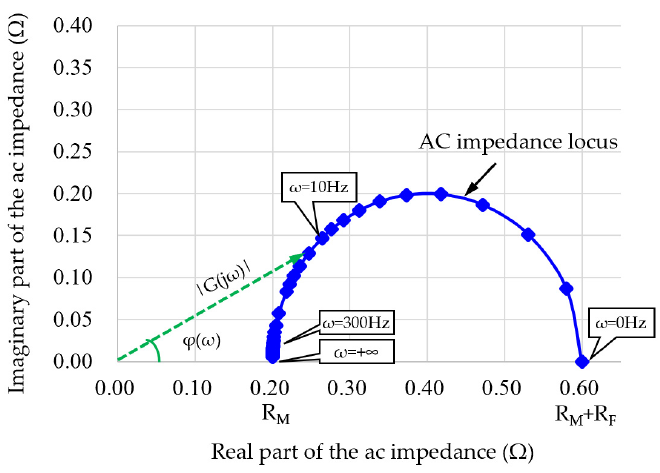
Figure 5. Nyquist plot for the ac impedance of the PEMFC stack under different frequencies.